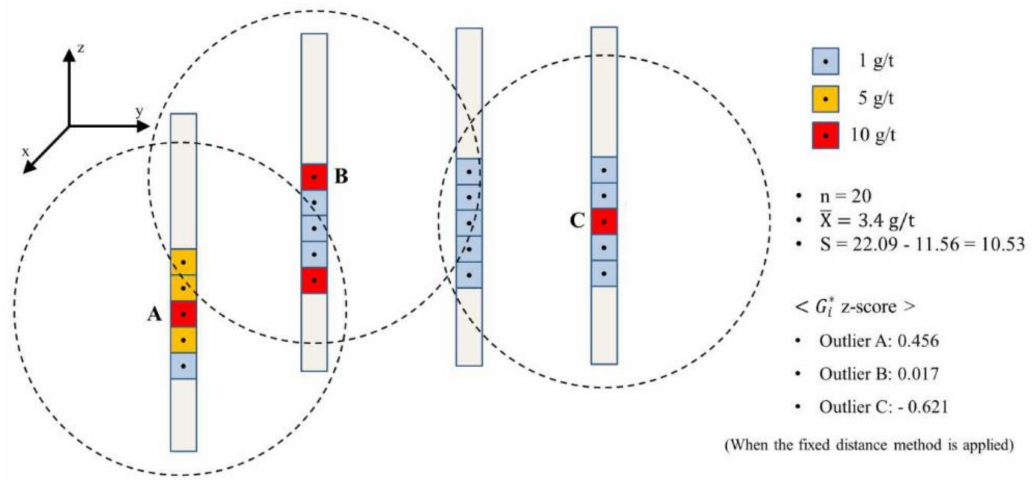
Figure 1. Schematic diagram of 3D hot-spot analysis for borehole data [16].